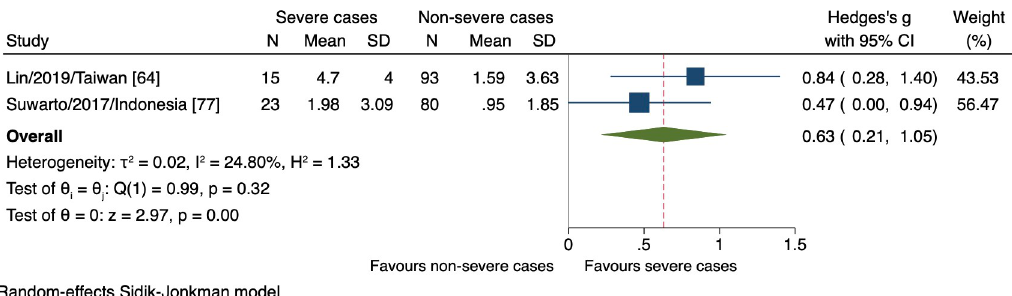
Fig 7. Forest plot showing the relationship between hyaluronan levels and severe dengue. The red dashed line represented the overall effect size.